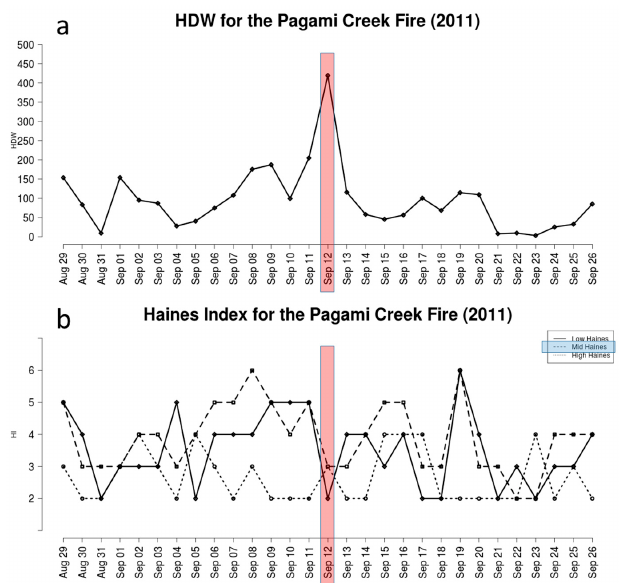
Figure 1. Time series using CFSR data at 48.0° N latitude and 91.5° W longitude from 29 August through 26 September 2011 of ( a ) HDW and ( b ) Low (solid line), Mid (dashed line), and High (dotted line) variants of the Haines Index. The vertical, shaded, red rectangles indicate the day on which the most rapid fire growth occurred on the Pagami Creek Fire. The Haines Index variant that is recommended for this location is shaded in